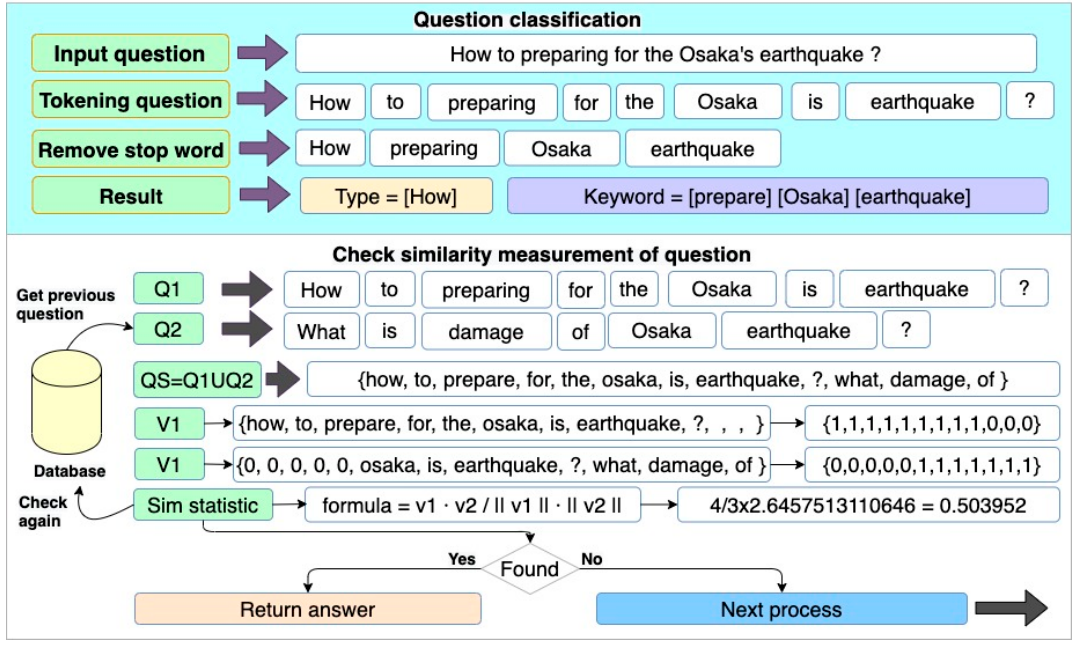
Figure 6. Question processing phase.